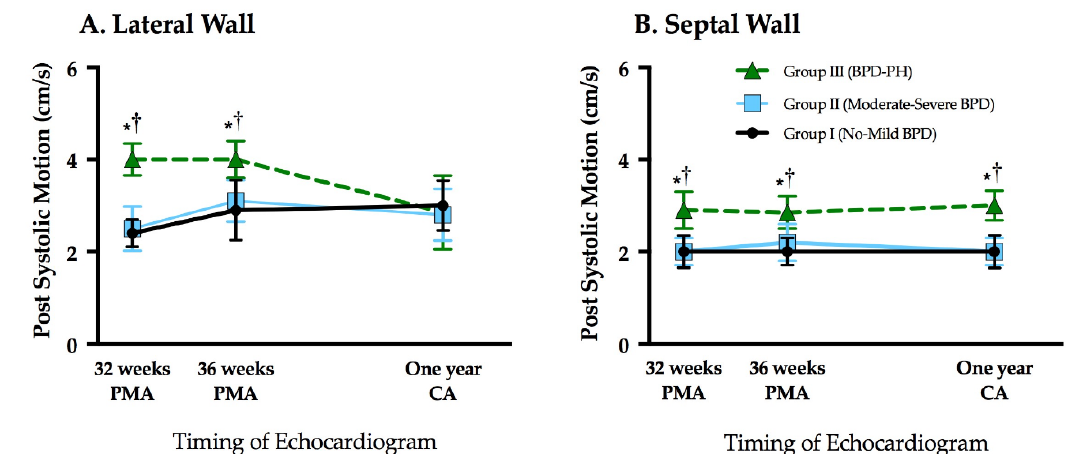
Figure 4. Post systolic motion (velocity) tracked over time in the ( A ) left ventricle and ( B ) interventricular septal wall between Group I, no-mild BPD (black dots), Group II, moderate-severe BPD (blue squares), and Group III, BPD-PH (green triangles). BPD, bronchopulmonary dysplasia; PH, pulmonary hypertension; PMA, postmenstrual age; CA, corrected age. * p < 0.05 Group I vs. Group III, comparisons adjusted for gestational age at birth, sex, and heart rate. † p < 0.05 Group II vs. Group III, comparisons adjusted for gestational age at birth, sex, and heart rate. Table 5. Comparison of LV tissue Doppler indices between term and preterm individuals at one year of age. Group I Group